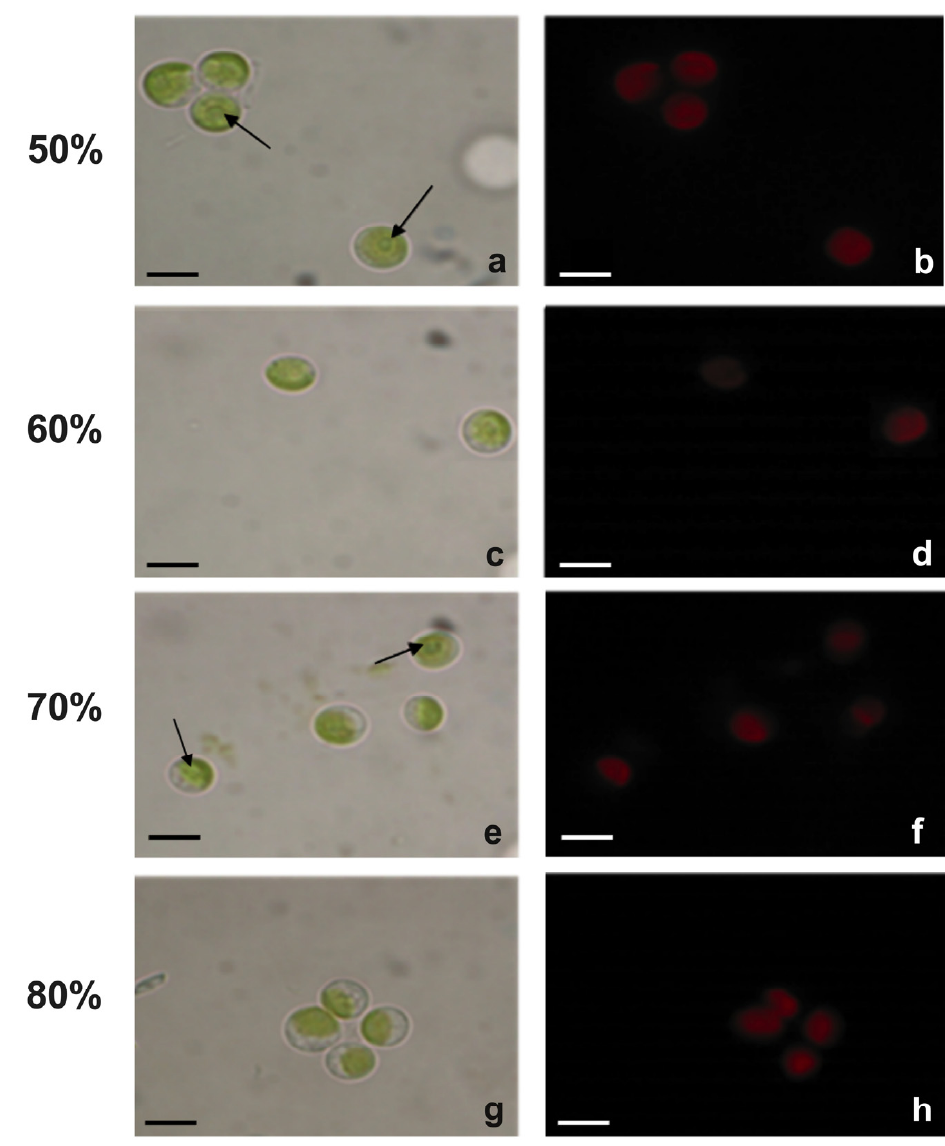
Figure 4. Light and fluorescence microscope images of Chlorella sp. cultivated in centrate stream diluted at 4 different concentrations: 50% ( a , b ), 60% ( c , d ), 70% ( e , f ) and 80% ( g , h ) of effluent. Images were taken at the end of the experiment (6 days). Figures ( a , c , e , g ) refer to images captured using the white light lamp of the microscope, while Figures ( b , d , f , h ) using the fluorescence lamp (excitation wavelength, 436 nm). Arrow, pyrenoid. Bars, 7 µm.